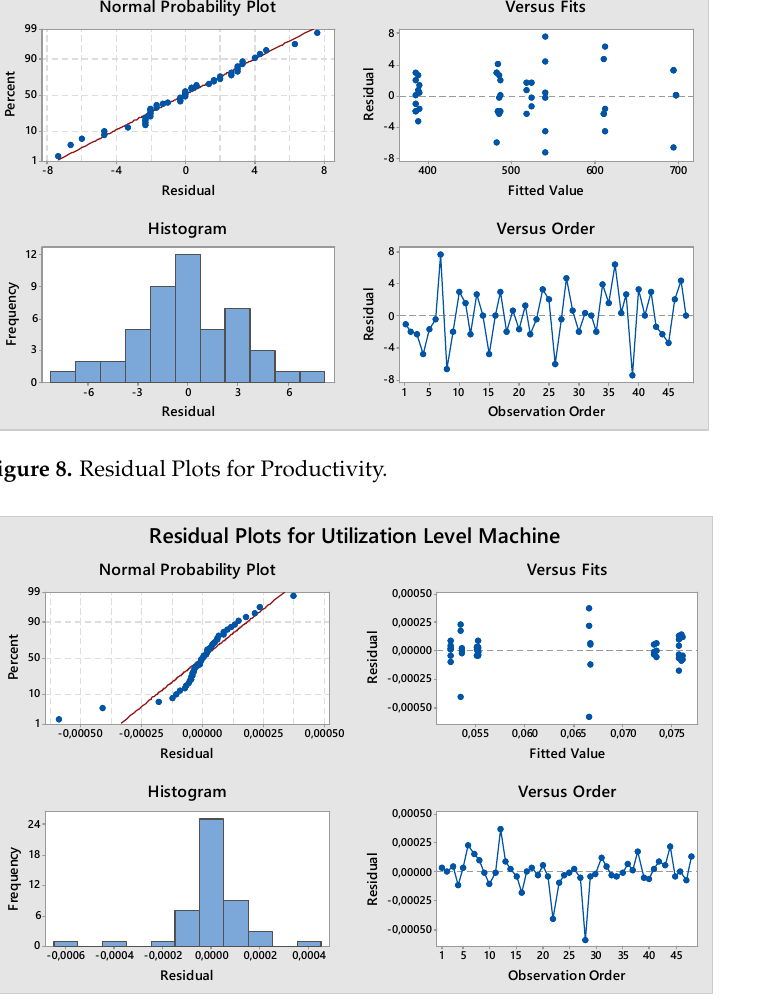
Figure 9. Residual Plots for Utilization Level Machine.